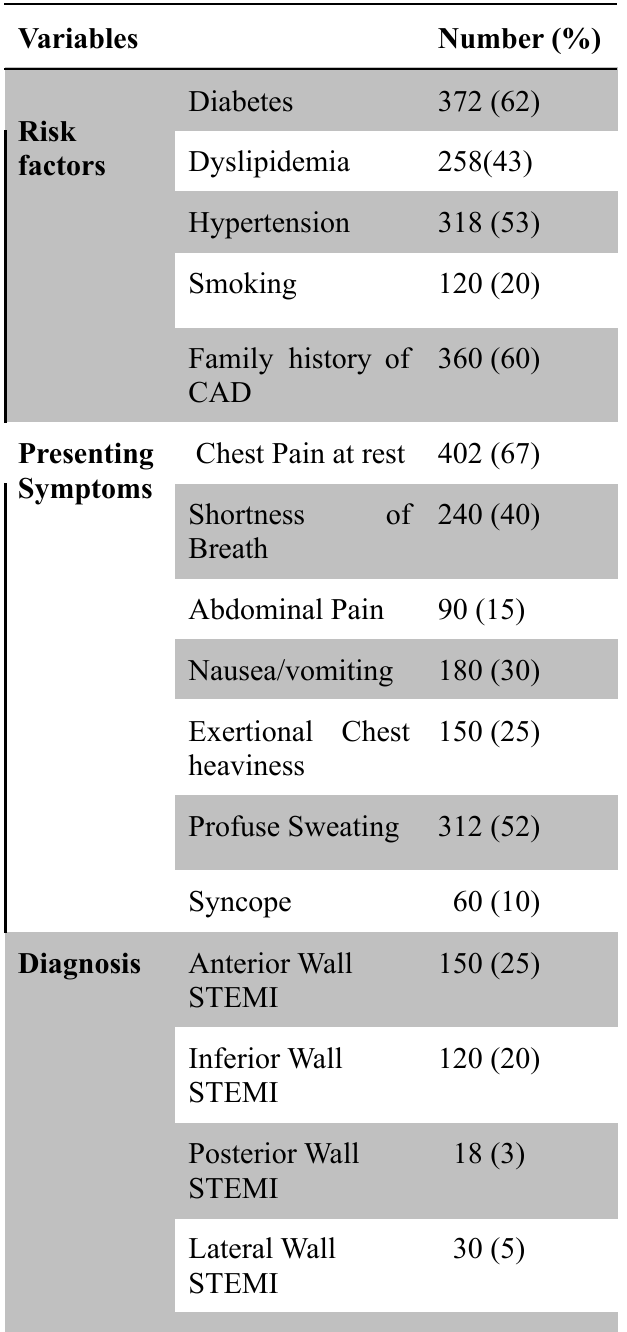
Table 2. Demographic characteristics, diagnosis and treatment strategy